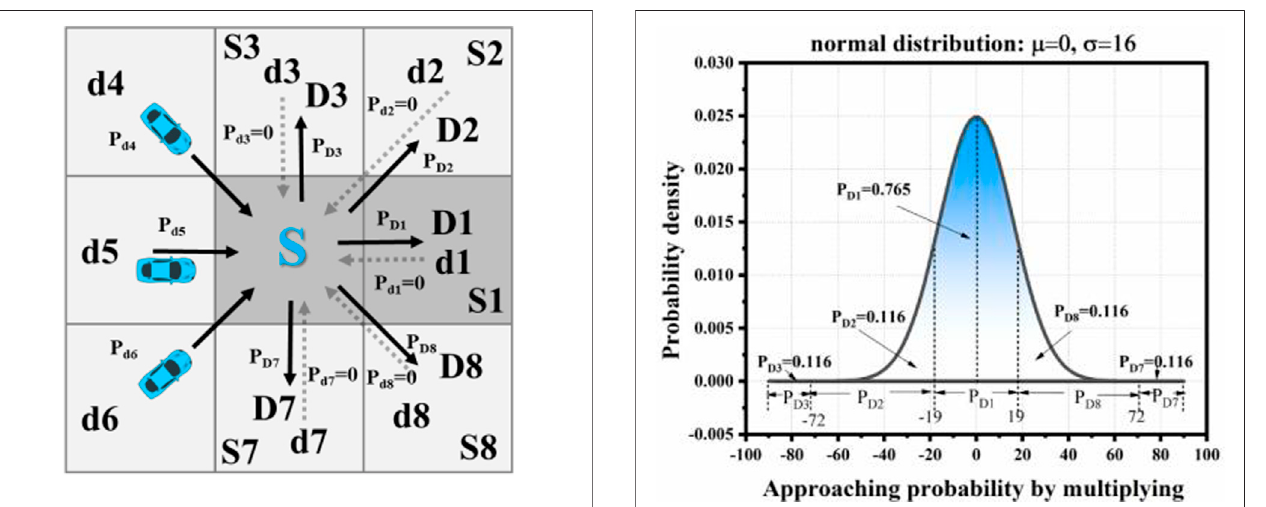
FIGURE 17 | Gaussian distribution of vehicles when D 5 enters D 1 and leaves. and leaving along D 1 direction, which corresponds to P D1 in the previous